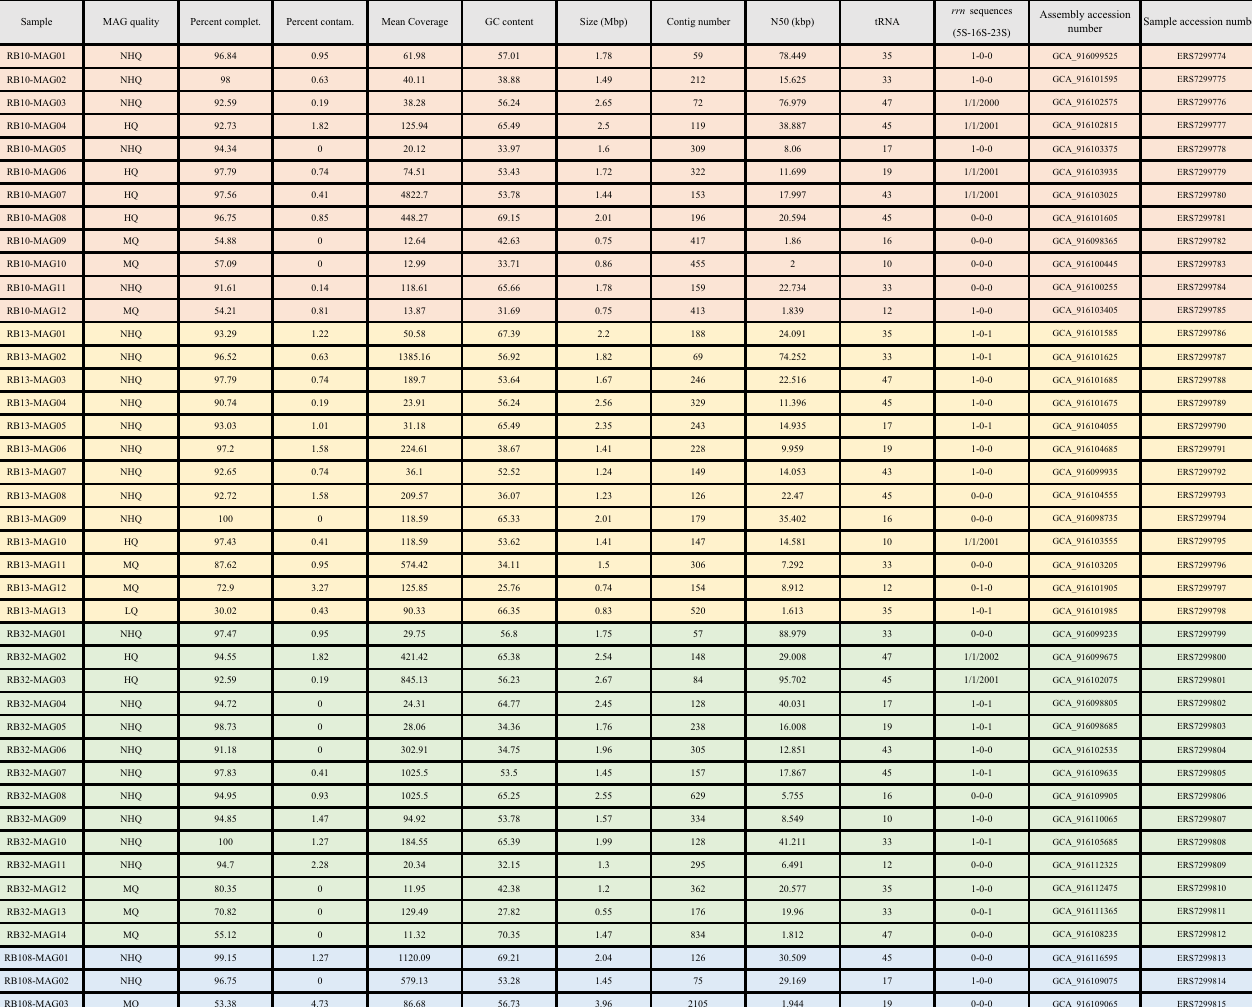
Table 1. General characteristics of the 42 MAGs obtained from RB10, RB13, RB32 and RB108 samples. In accordance with current standards, the bins were defined as high quality (HQ) (> 90% completion, < 5% contamination, presence of the 23S, 16S and 5S rRNA genes and at least 18 tRNAs), near high quality (NHQ) (> 90% completion, < 5% contamination, other criteria partially covered), medium quality (MQ) (≥ 50% completion, < 10% contamination), and low quality (LQ) (< 50% completion, < 10% contamination) MAGs. Metagenomes and MAGs accession numbers are available on ENA (Study ID: